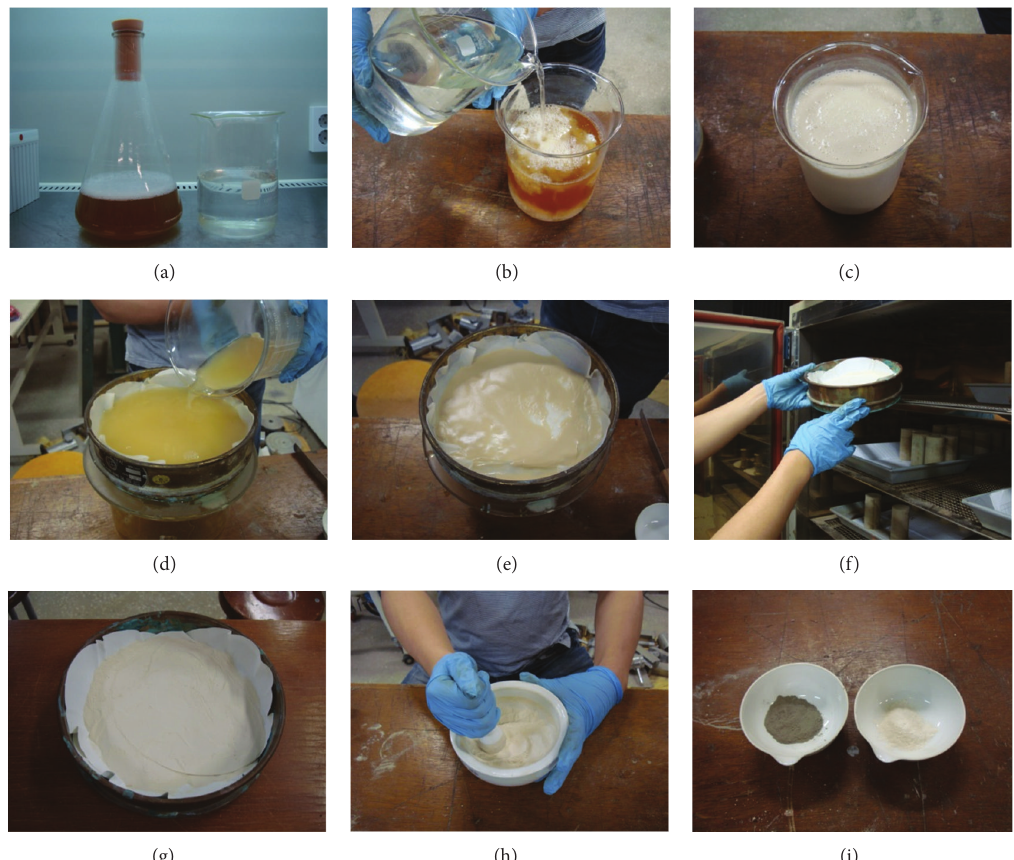
Figure 3: Extracting and producing calcium